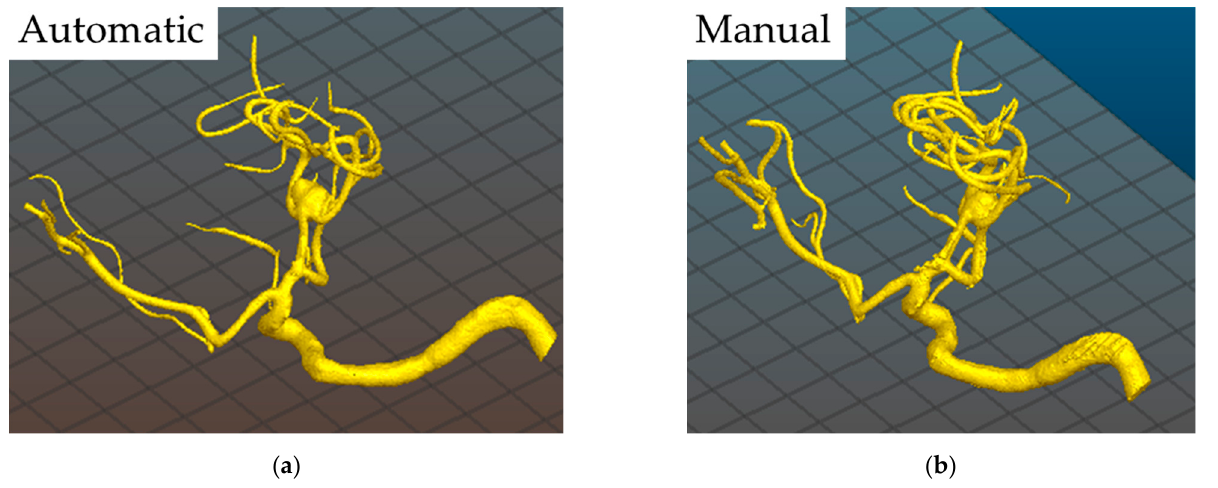
Figure 3. Comparison of reconstruction methods for the reproduction of the images’ contours for the elaboration of the STL file from the DICOM data: ( a ) automatic contour; ( b ) manual contour.